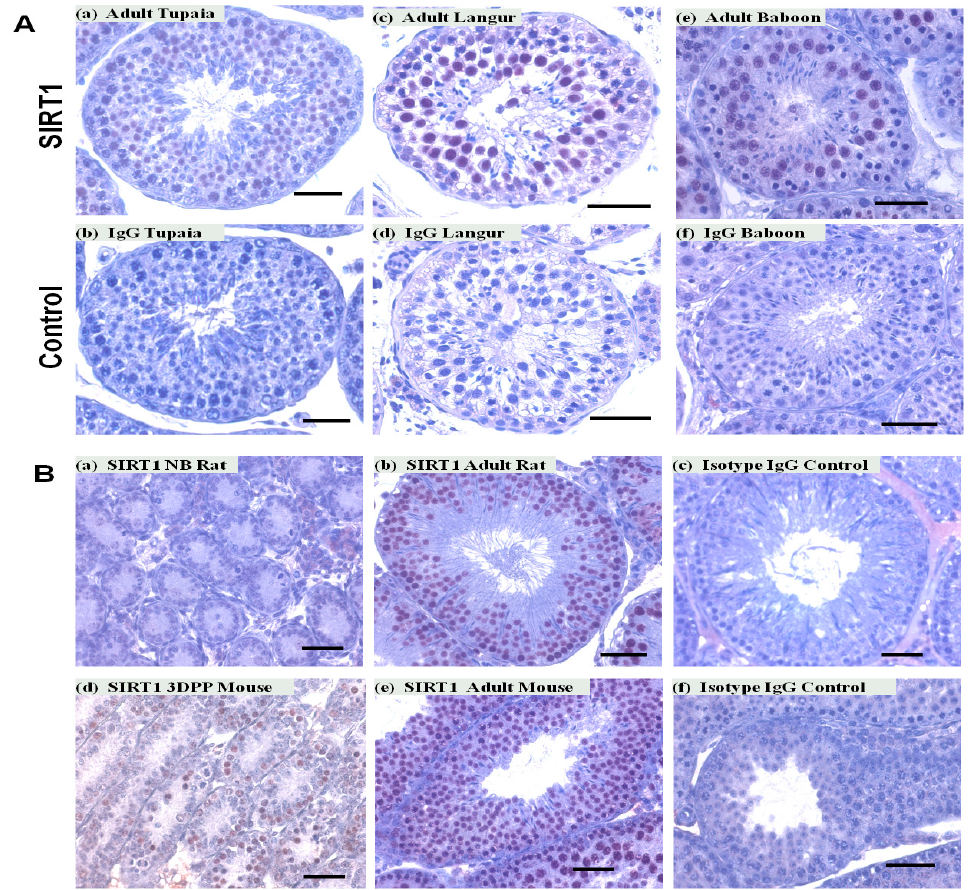
Figure 3. SIRT1 expression in testes of different primates and non-primates species. SIRT1 expression was observed in cells of the tubular compartment of tupaia ( A )a, langur ( A )c, baboon ( A )e, rat ( B )a,b, and mouse ( B )d,e testes. No staining was noted in IgG controls. Scale bars, 50 µm.